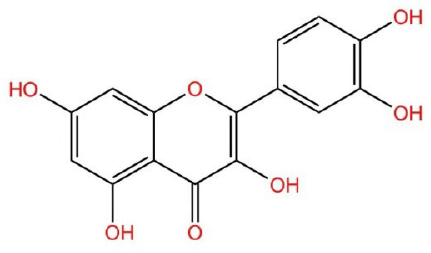
Figure 1. Structural formula of quercetin.